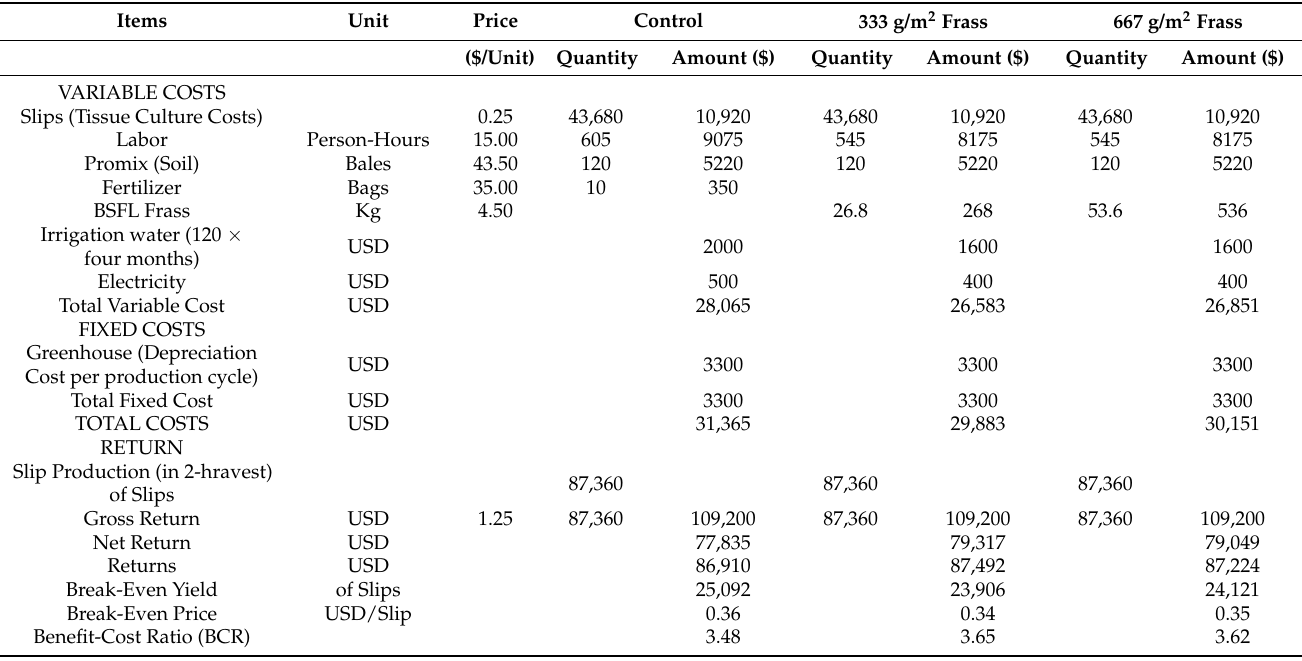
Table 5. Enterprise budget for sweetpotato slip